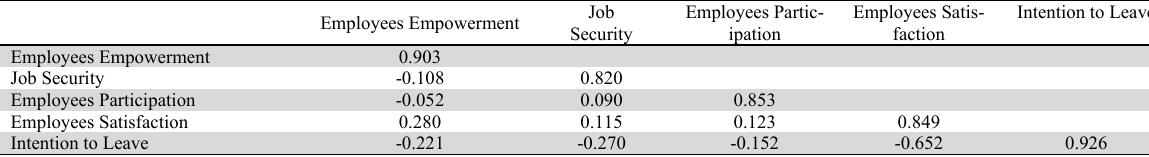
Discriminant Validity Based on Fornell-Larcker Criteria